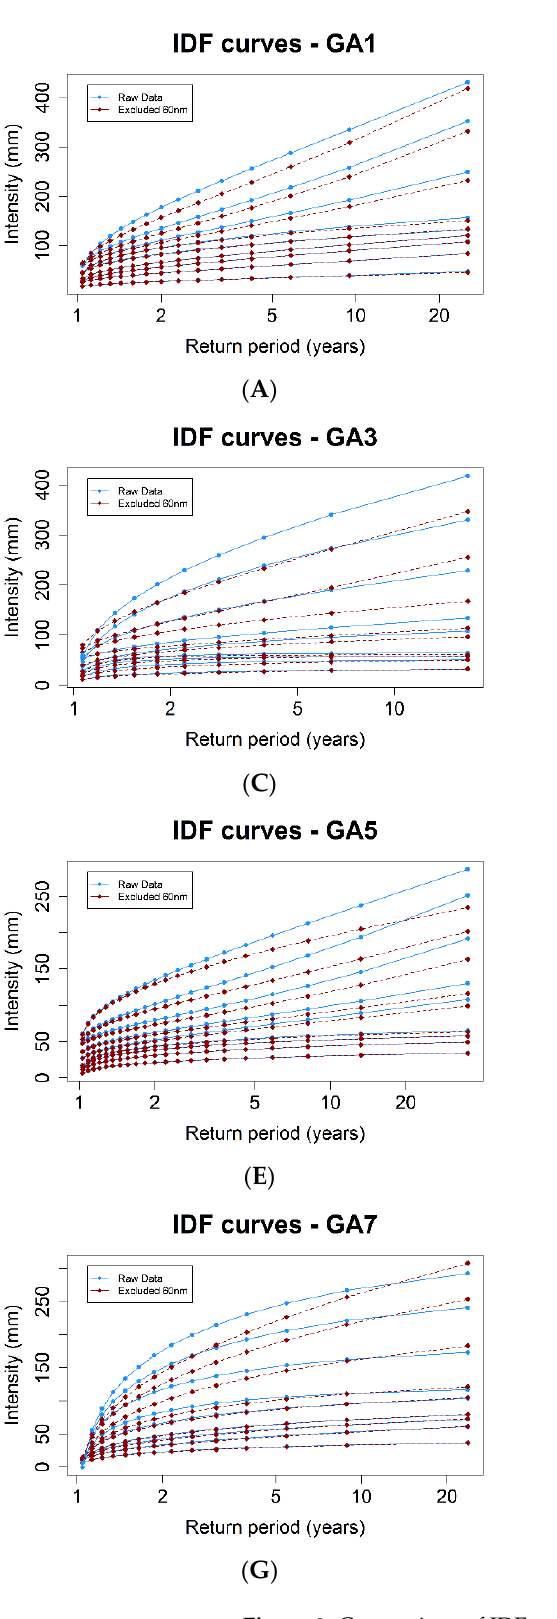
Figure 9. Comparison of IDF curves for accounting for typhoon effects on IDF curves. The estimated IDF curves for Almagosa ( A ), Fena Lake ( B ), Geomag ( C ), Mt. Chachao ( D ), Mt. Santa Rosa ( E ), Umatac ( F ), and Windward Hills ( G ), respectively.